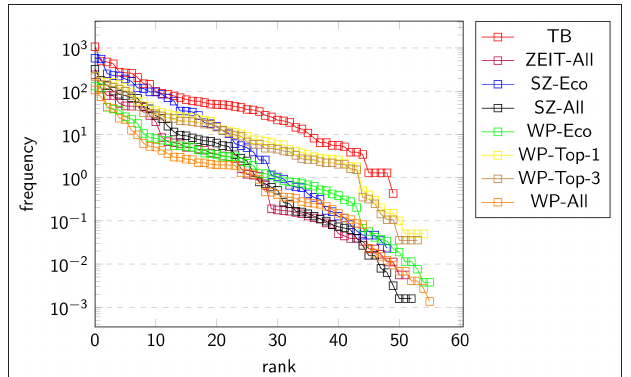
FIGURE 3 | Rank-specificity distribution of threshold concepts based on lemma frequencies.